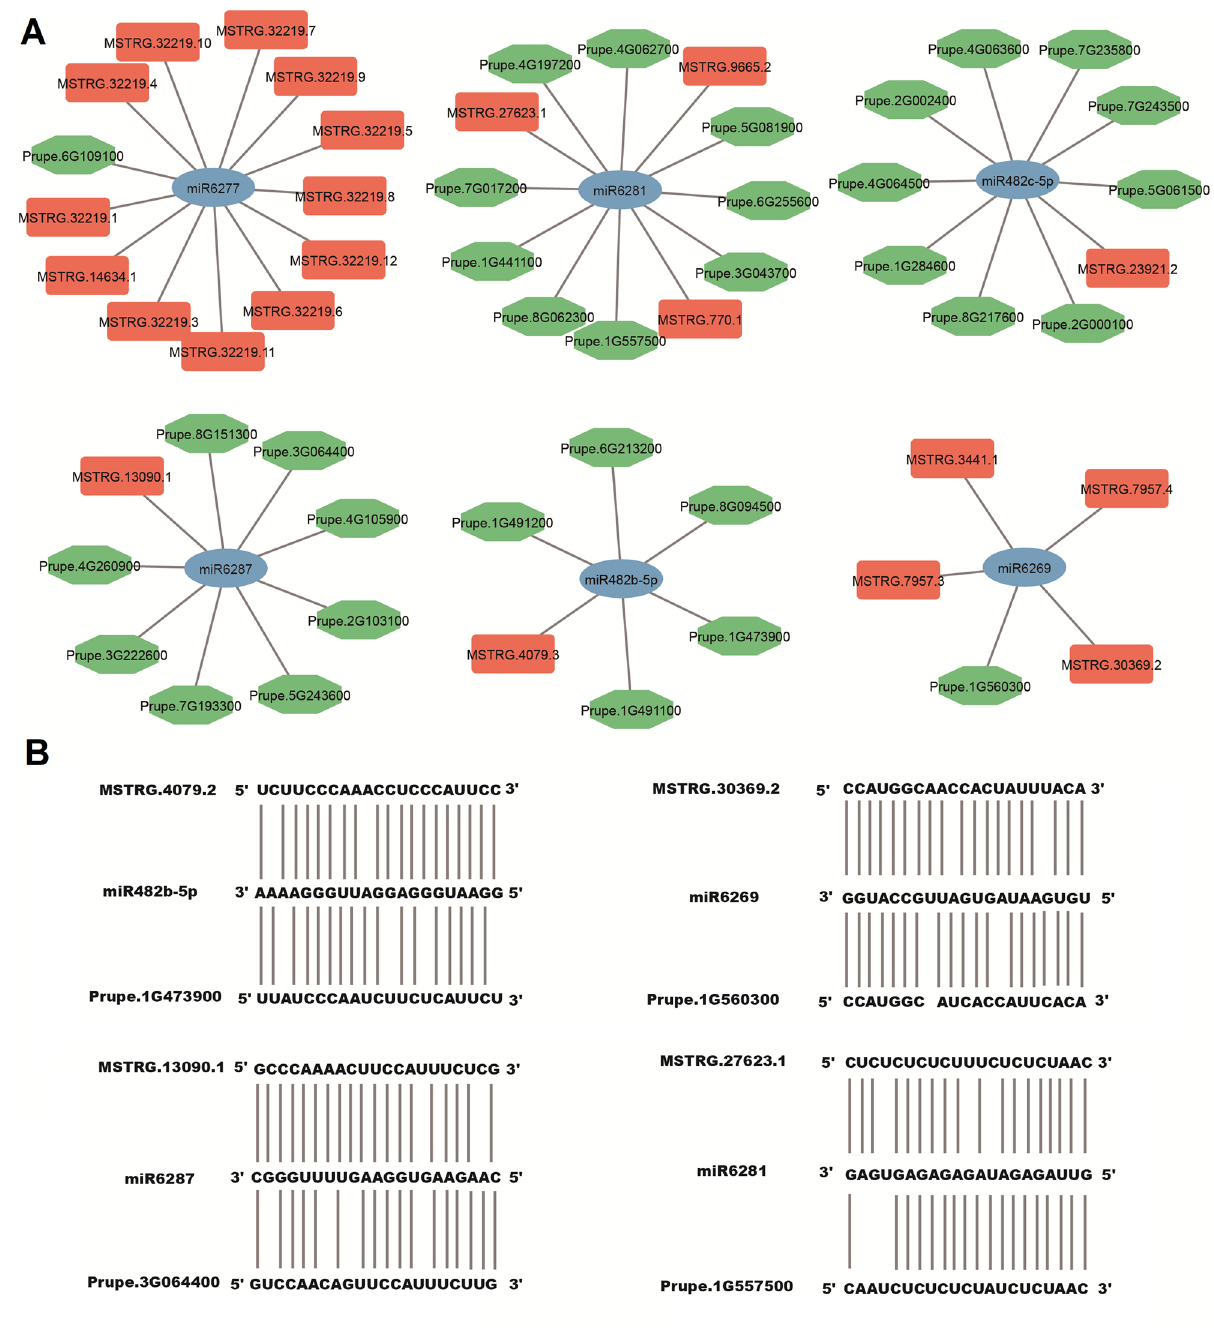
Figure 8. Competing endogenous RNA (CeRNA) networks of peach lncRNA-miRNA-mRNA. ( A ) Interaction networks of miRNA-lncRNA and miRNA-mRNA. ( B ) Sequence complementarity of lncRNA-miRNA-mRNA. Mature miRNA sequences and corresponding partial lncRNA or mRNA sequences were used for